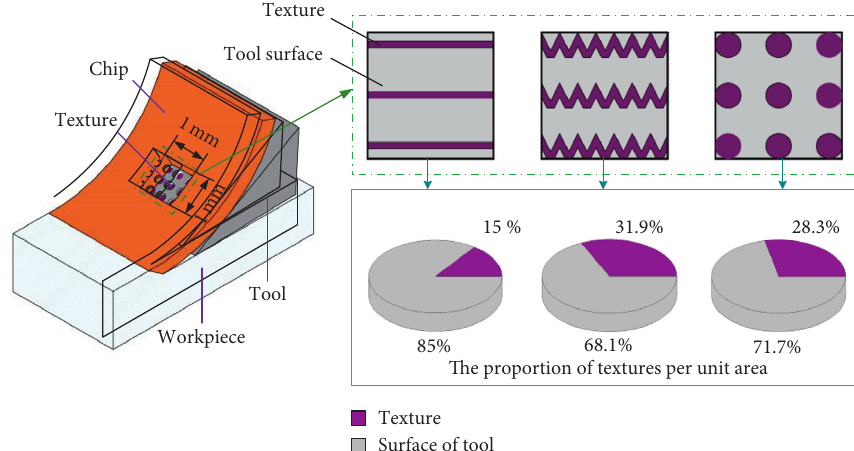
Figure 6: Proportion of the unit area of different textures on the tool